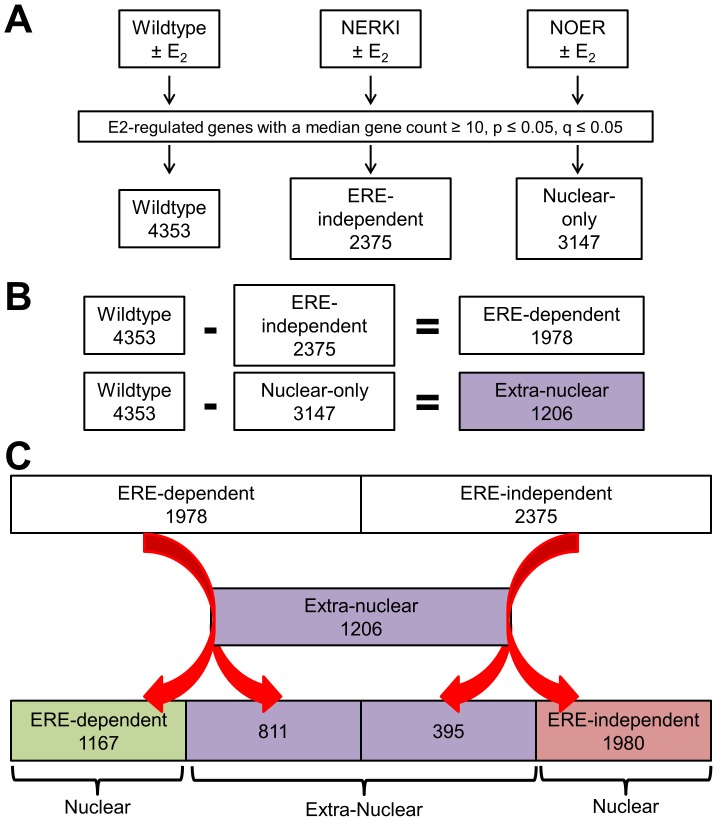
Flow-chart detailing our data analysis strategy (described in detail in the text).